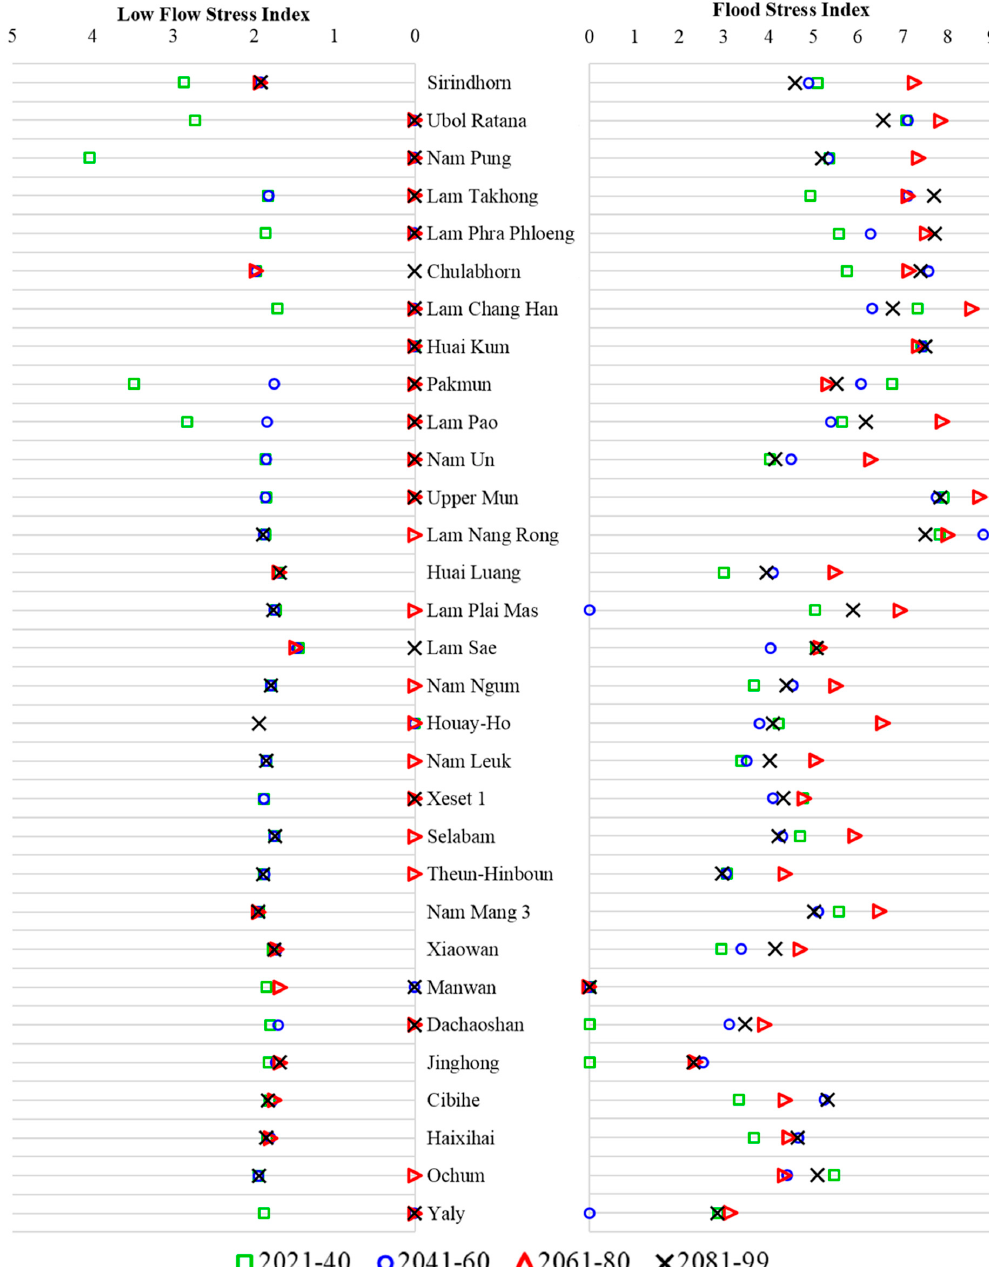
Figure 3. Stress index of the MRB dams for flood and low flow events during the four timespans; 2021–2040 (green square), 2041–2060 (blue circle), 2061–2080 (red triangle), and 2081–2099 (black cross) using four climate models under RCP 4.5 and RCP 8.5.